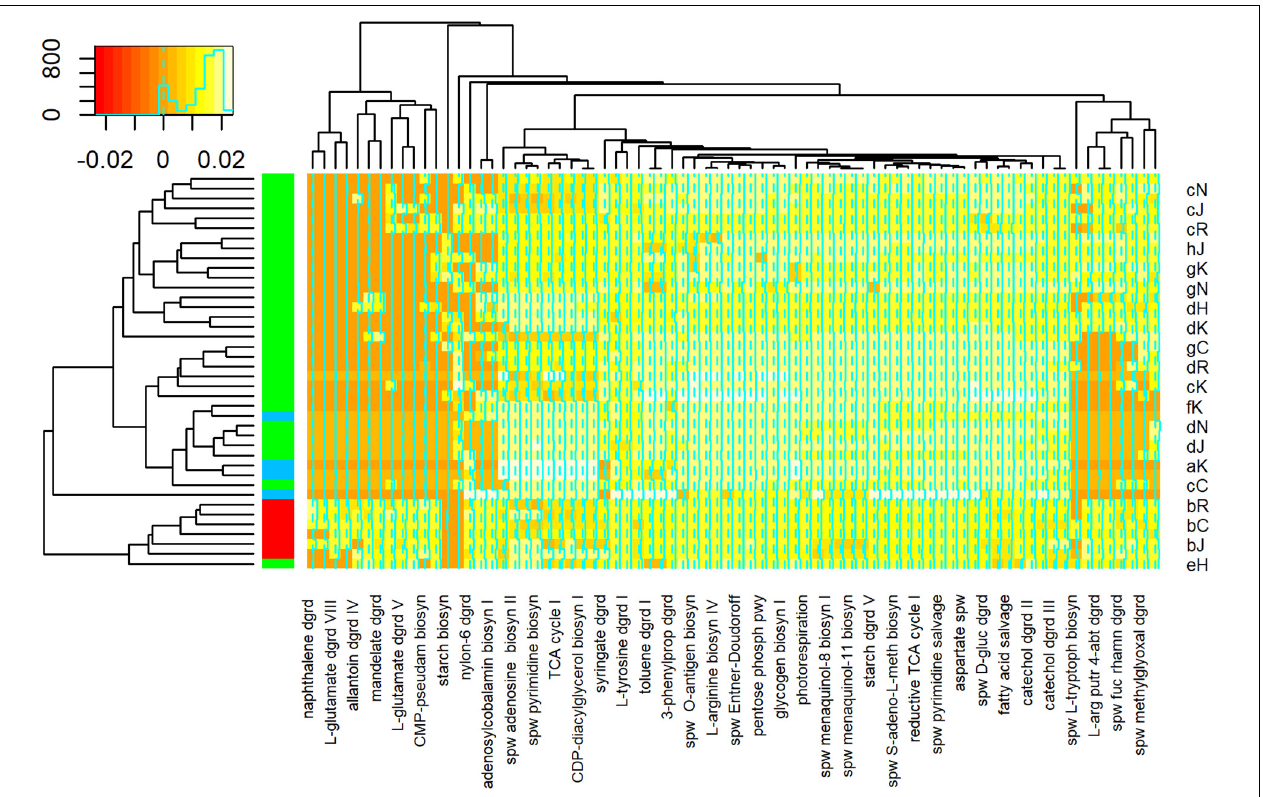
FIGURE 8 | Heatmap of Metabolic Pathway Abundances. Pathways on lower horizontal axis were predicted from ASVs with PICRUSt2 as described in Methods. Representative sample codes are indicated on right vertical axis, where lower case letter indicates date (see Supplementary Figure 1 ) and upper case letter indicates station (see Figure 1 ). Sample types are indicated by colors in block on left vertical axis, where blue = pre, red = HH, and green = post. Inset shows key for counts of pathways in colors and a histogram. Figure was generated with scripts in Supplementary File 15